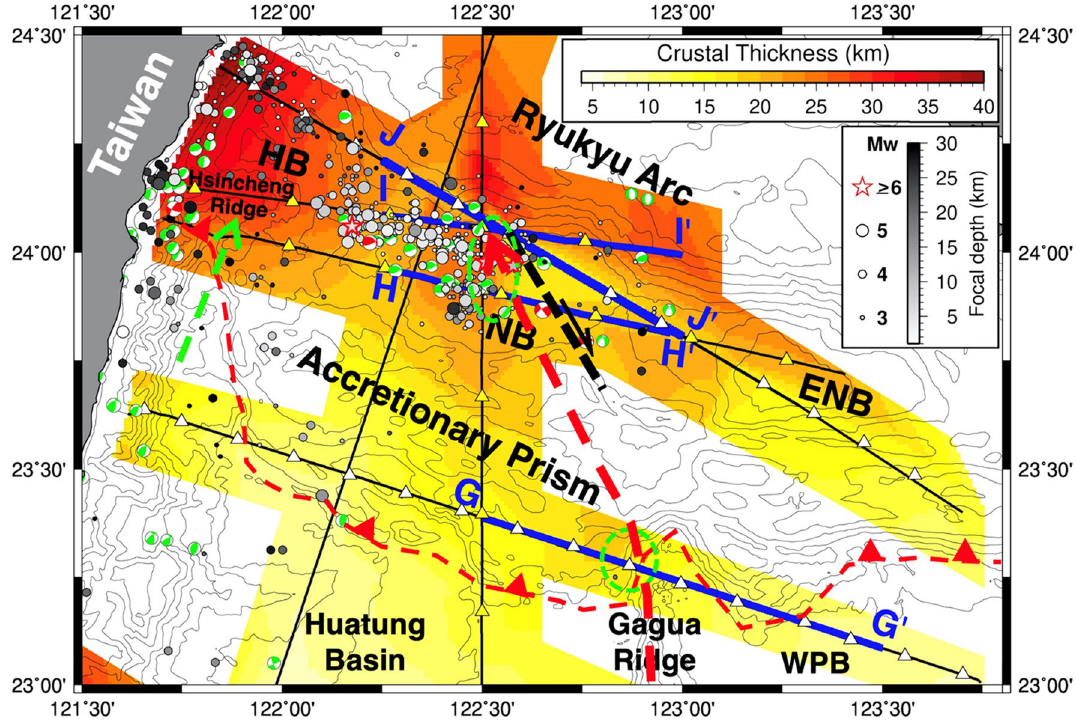
Fig. 12 The crustal thickness near the southernmost Ryukyu Trench superimposed by the relocated earthquakes in 1992–1997 (Font et al. 2004). The red dashed line indicates the Ryukyu Trench with the red triangles which show the direction of subduction. The focal mechanisms of the earthquakes with the depth of ≤ 30 km are shown by the red (Mw ≥ 6 ) and green (6 > Mw ≥ 5) beach balls. The location of uplifted structures is ranged by the green circles. The right‑lateral strike‑slip fault (Wang et al. 2019) is indicated by the black dashed line. The red and green dashed‑line arrows show the directions of the obliquely subducted Gagua Ridge and the subducted PSP, respectively. The schematic diagram of the velocity‑interfaces models along Lines GG’, HH’, II’, and JJ’ which, indicated by the blue lines, are shown in Fig. 13. The contour lines are bathymetry with the contour interval of 500 m. WPB: West Philippine Basin; HB: Hoping Basin; NB: Nanao Basin; ENB: East Nanao